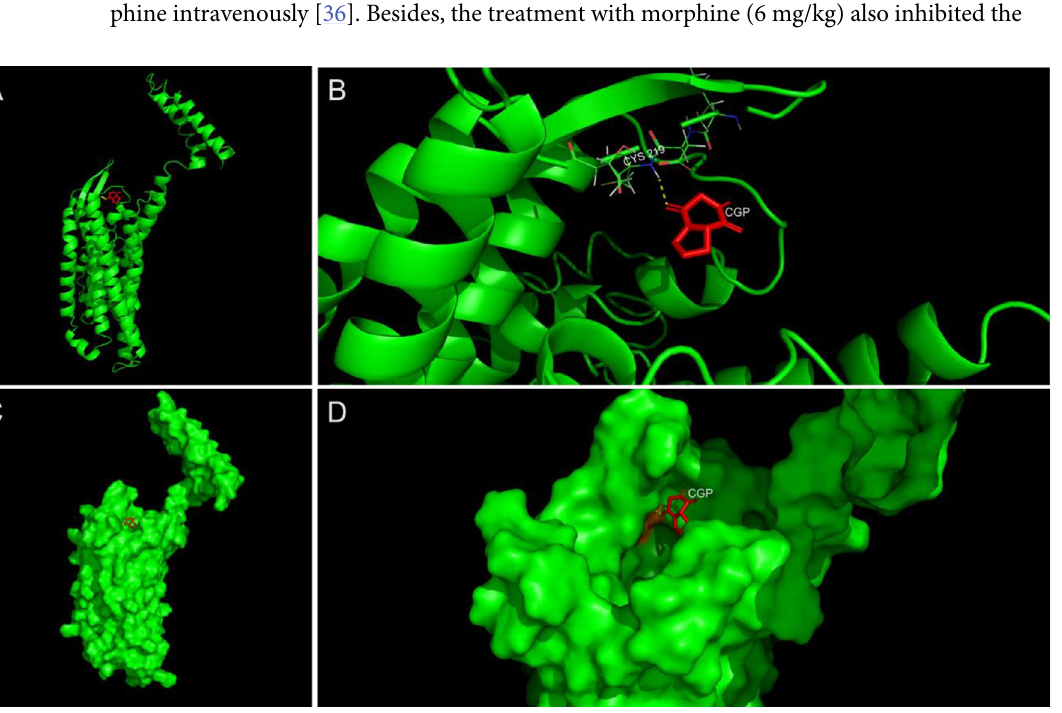
Fig 4. Chemical compounds profile in submandibular gland represented by means of ATR-FTIR spectra of Swiss mice after acute treatment with vehicle, morphine or CGP in the presence or absence of naloxone. (A) ATR-FTIR spectra displayed in 1800–800 cm -1 region. The major vibrational modes are represented, indicating changes under the acute treatment with CGP or morphine on the various chemical compounds present in the submandibular gland. These changes were reversed by naloxone pre-treatment. (B) Amide I (1687–1594 cm-1), (C) Amide II (1594–1494 cm -1 ), (D) CH2/CH3 (1488–1433 cm -1 ), (E) C = O (1432–1365 cm -1 ), (F) PO 2 asymmetric (1290–1185 cm -1 ) and (G) PO 2 asymmetric (1135–999 cm -1 ). (H) Heat map with the relative expression of each vibrational mode (Vehicle expression was set as 100%). Results are represented as mean ± SEM of 6 animals.